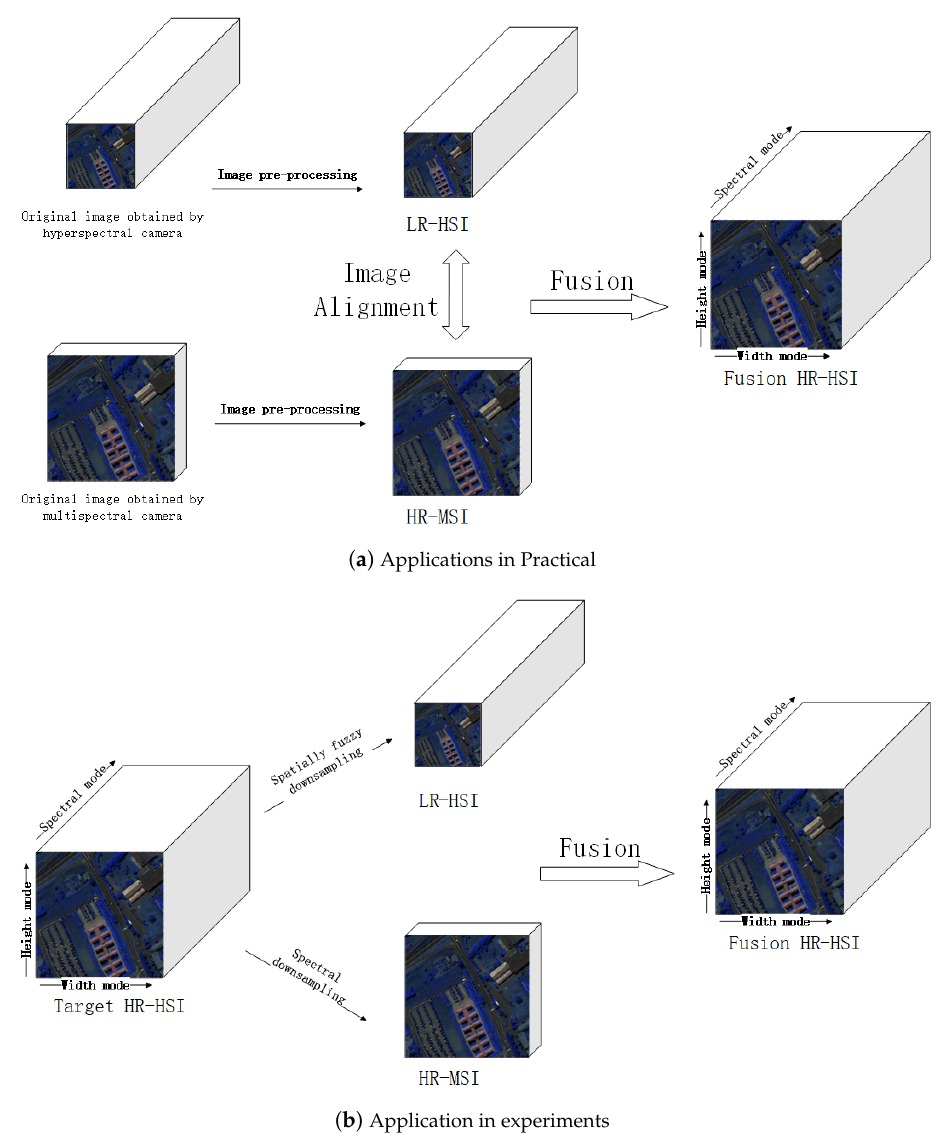
Figure 1. Flowchart for achieving super-resolution using a fusion